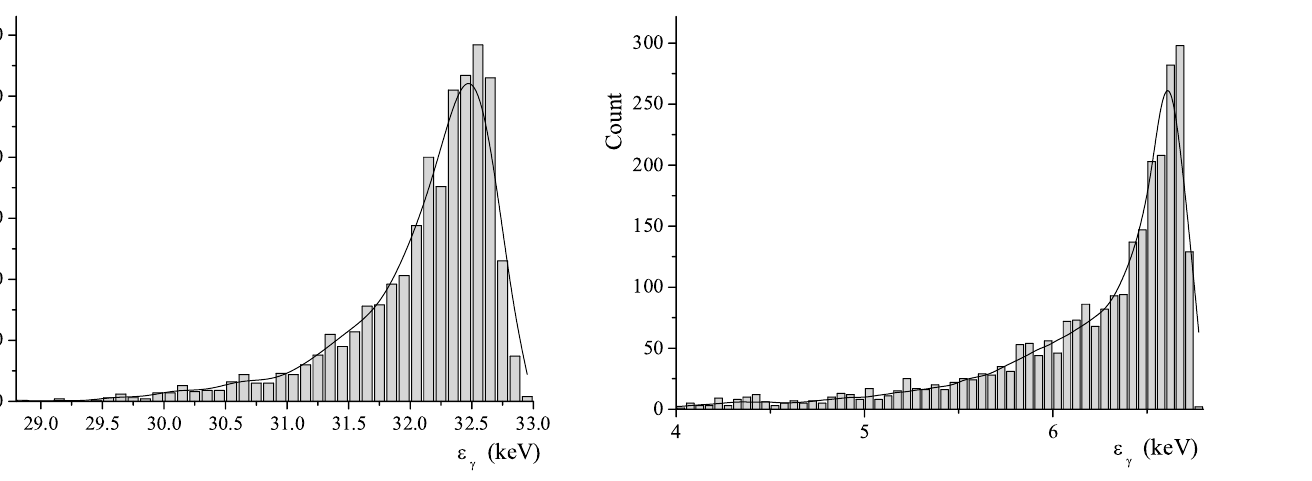
(cid:2) 4 (cid:14) sented in Fig. 9. Total Compton beam intensity n (cid:2) 10 10 phot = s , number of photons within the collimation (cid:1) 1 mrad is n (cid:2) 1 : 1 (cid:14) 10 9 phot = s , spec- angle (cid:12) (cid:2) col col trum width (FWHM) is approximately equal to 10% .